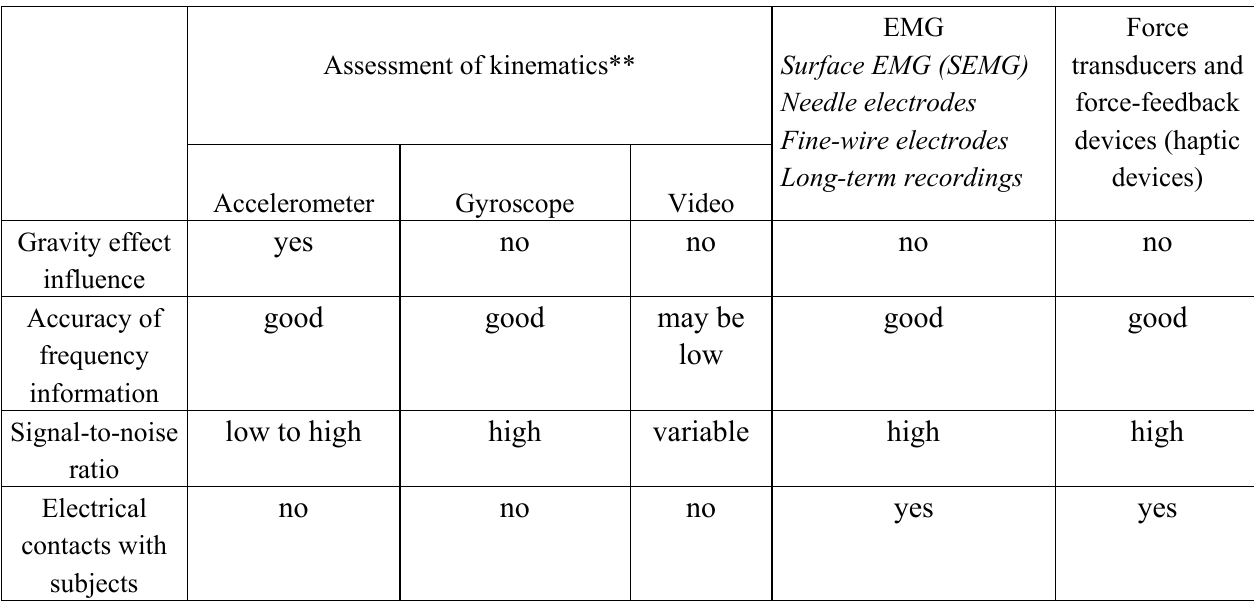
Table 3. Comparison of the most commonly used sensors for quantification and monitoring of tremor